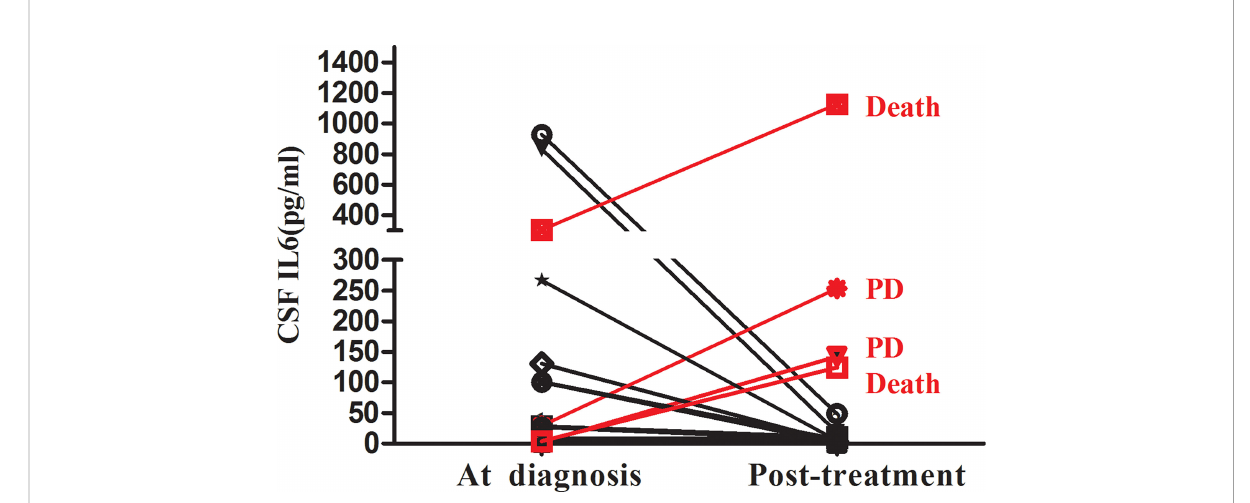
FIGURE 4 Changes in the CSF IL-6 level between AML with CNS involvement during diagnosis and post-treatment